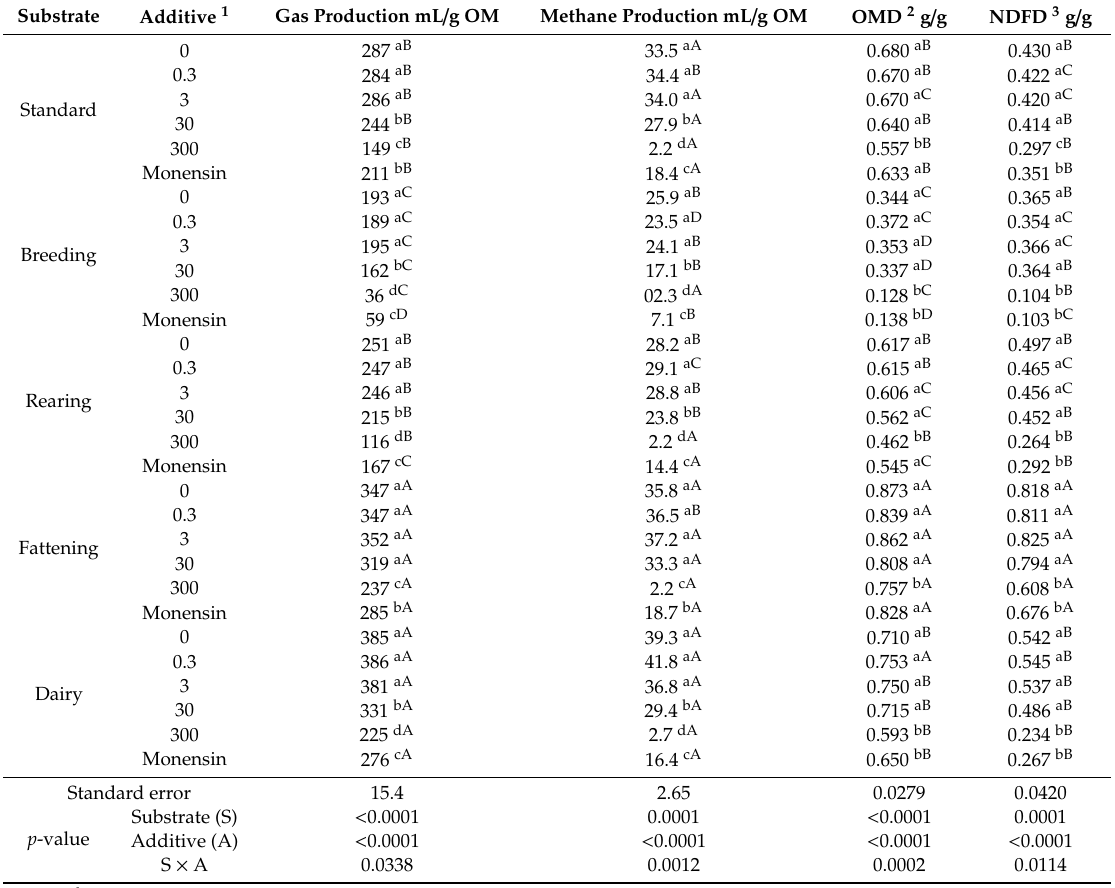
Table 3. E ff ects of increasing doses of essential oil of Tagetes minuta or monensin addition on total gas and methane production and organic matter and fiber digestibility during the in vitro fermentation of substrates, representing di ff erent livestock production system diets and a laboratory standard